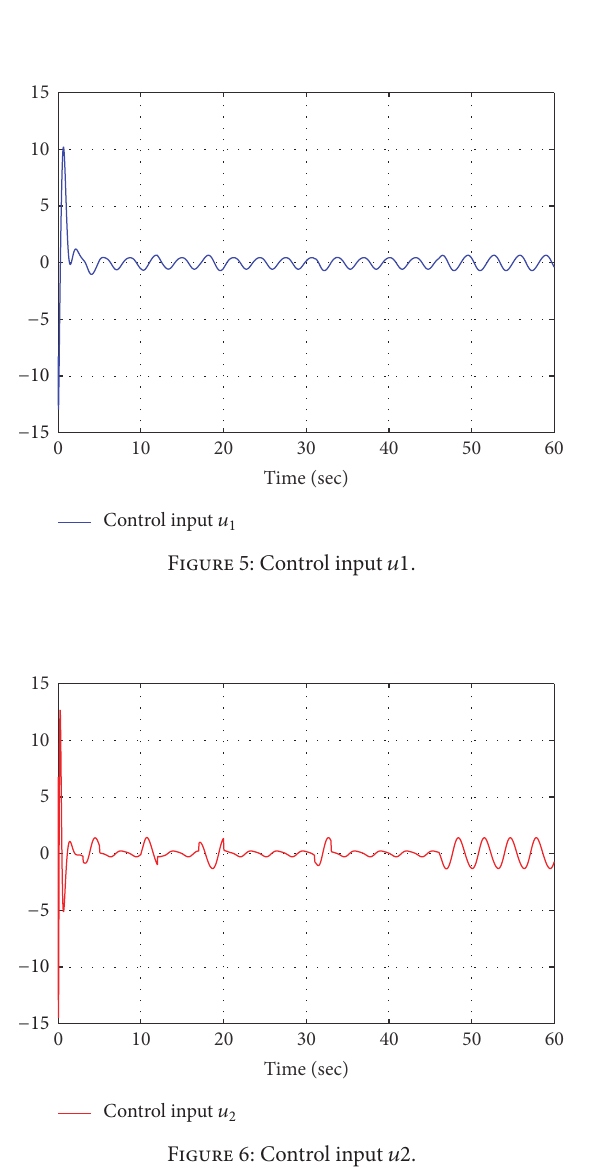
Figure 6: Control input 𝑢2 .